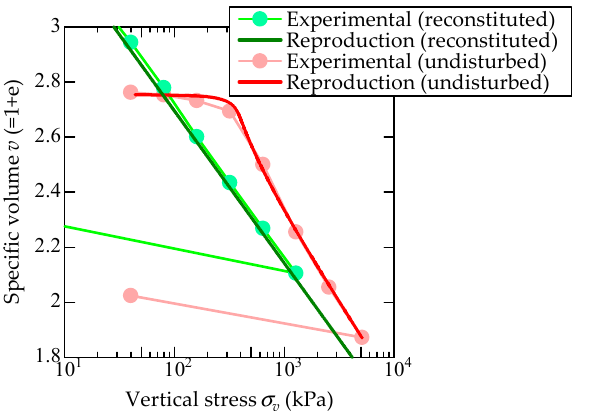
Figure 3. Standard consolidation test of the Ylc layer (experimental and reproduction results).